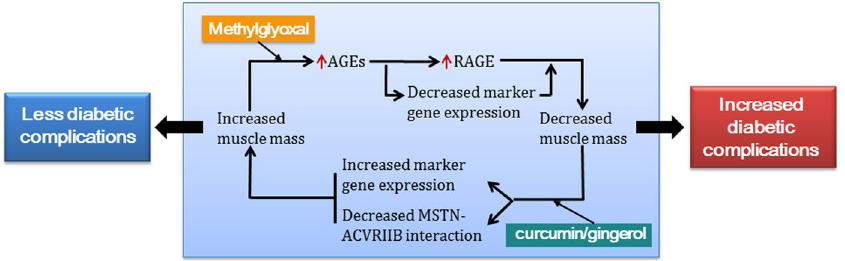
Figure 6. Hypothetical depiction of the adverse effects of AGEs on muscle in diabetes and the inhibition of these effects by dietary curcumin or gingerol